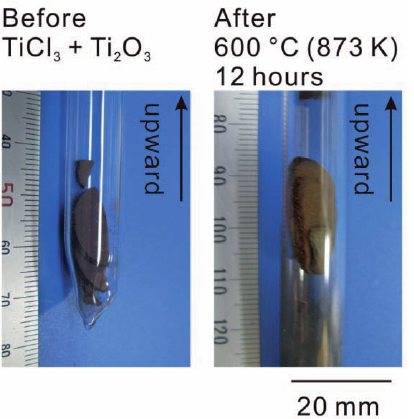
Figure 8. Photographs of the mixture of TiCl 3 and Ti 2 O 3 before and after heat-treatment and a photograph of the obtained TiOCl.